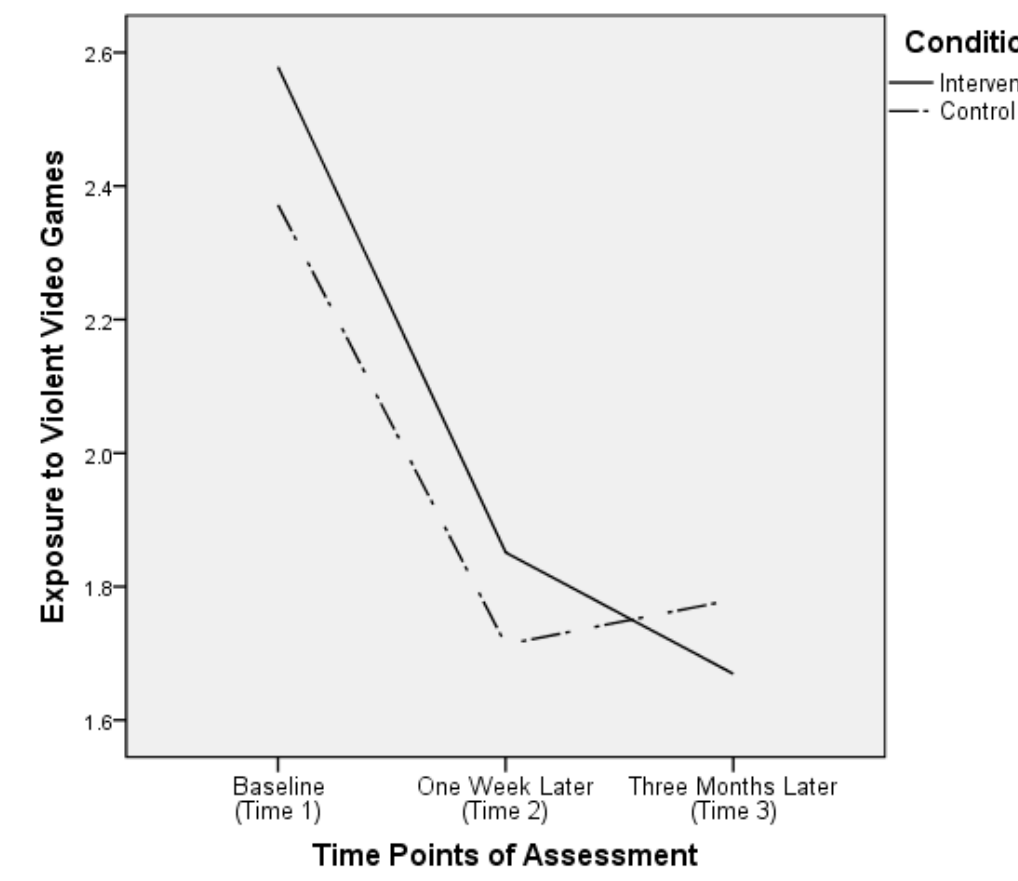
Figure 2. Parent report of children’s exposure to violent video games by time and condition.